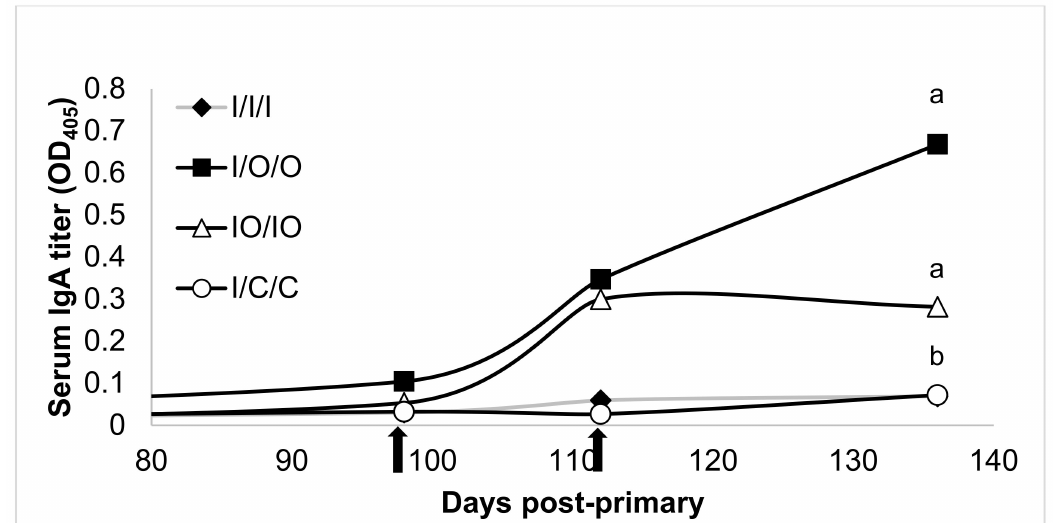
Figure 3. Serum IgA response to injected, oral, co-administered injected / oral or control treatments of HBsAg. Treatment groups, arrows, and statistical analysis as in Figure 1.